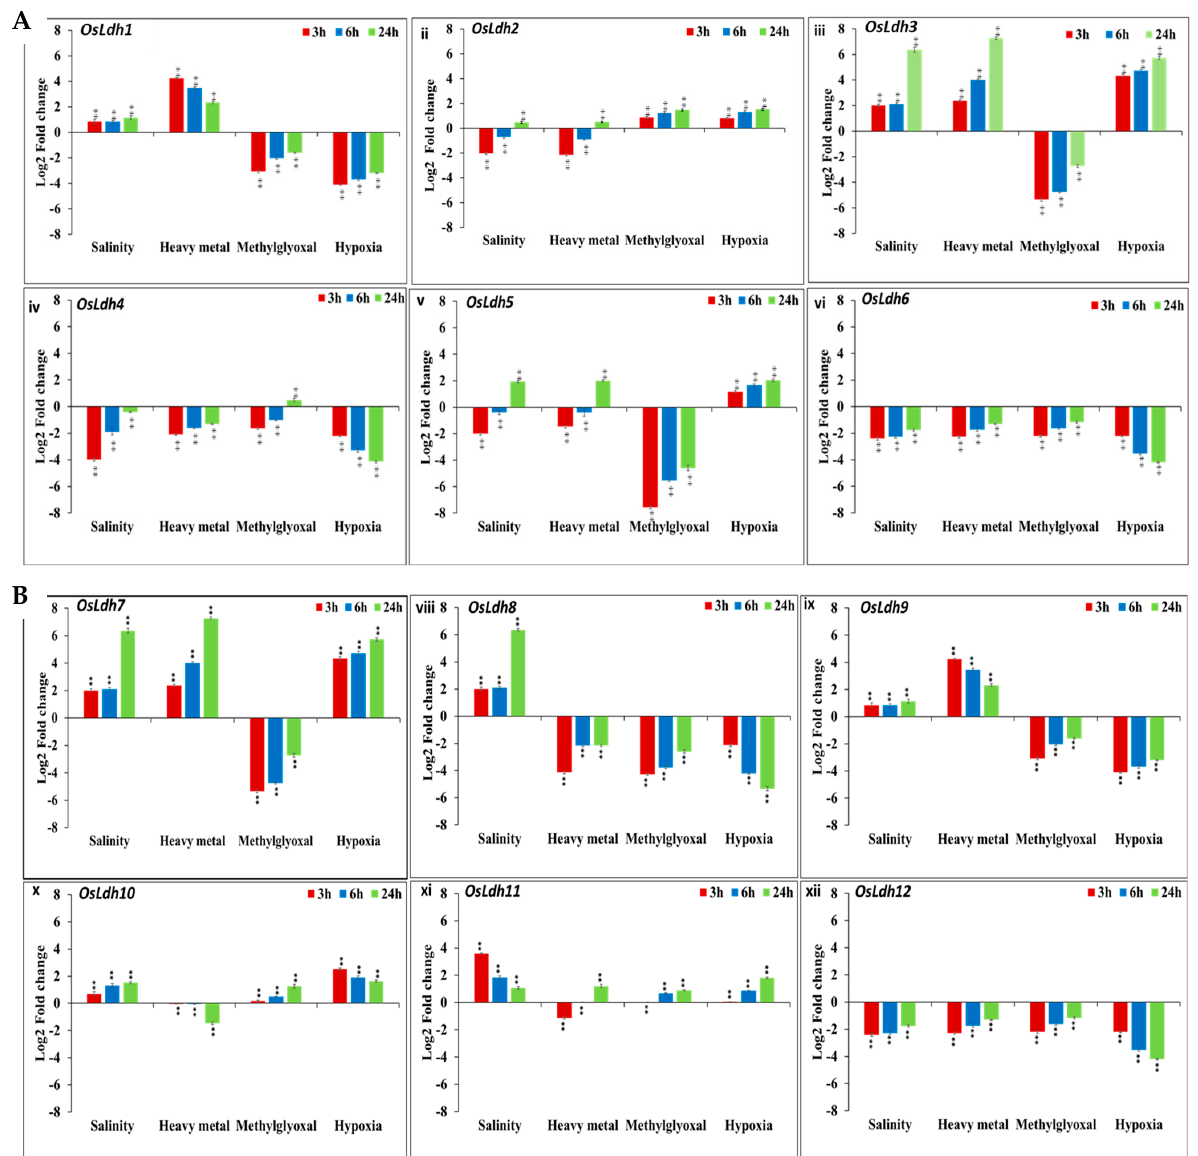
Figure 6. Transcript abundance analysis of OsLdh members under various stress conditions as determined by real time expression analysis. Bar graphs depicting expression levels of ( A ) ( i ) OsLdh1 , ( ii ) OsLdh2 , ( iii ) OsLdh3 , ( iv ) OsLdh4 , ( v ) OsLdh5 and ( vi ) OsLdh6 ; ( B ) ( vii ) OsLdh7 , ( viii ) OsLdh8 , ( ix ) OsLdh9 , ( x ) OsLdh10 , ( xi ) OsLdh11 and ( xii ) OsLdh12 genes under different abiotic stress treatments viz. salinity (200 mM), heavy metal (arsenic, 100 µM), methylglyoxal (10 mM), and hypoxia (given to 21 d old seedlings for 24 h). Expression levels (log2-fold change) have been calculated with respect to the untreated control (having value of 0). Statistical analysis has been performed with three replicates using Student’s t -test. ** signifies p value < 0.05 up to three or more decimal places and * signifies p value < 0.05 for two decimal places.